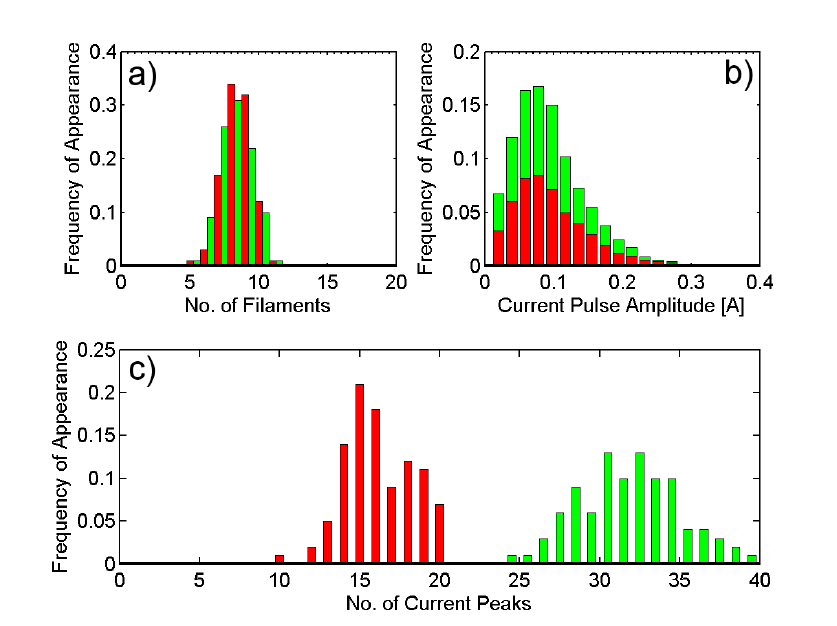
Figure 9 : Histograms of: a) number of filaments, b) distribution of microdischarges current and c) number of microdischarges. Red bars correspond to positive half-period of discharge; green bars correspond to whole period of the discharge. Discharge conditions were as follows: DCSBD generated using sine-wave HV of the amplitude of 18 kV, electrode gap width set to 2.0